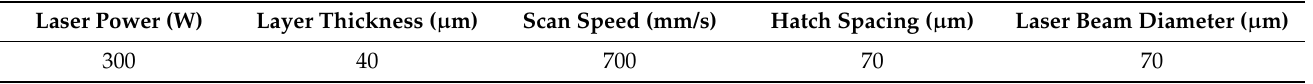
Table 1. Printing parameters used for the SLM process.